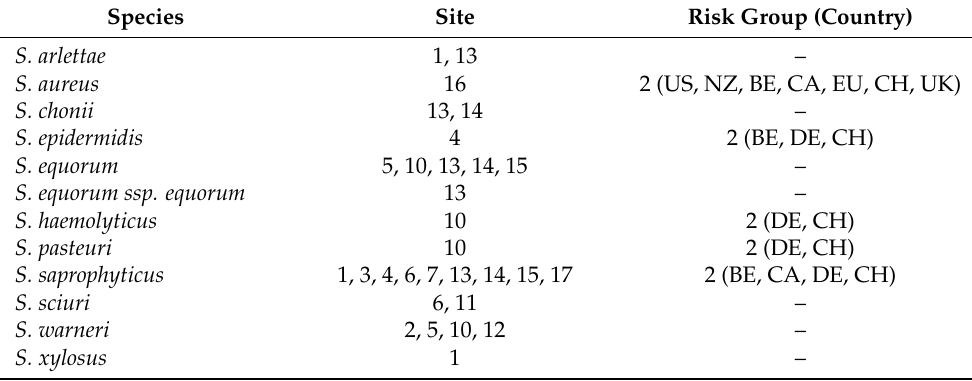
Table 2. Staphylococcus isolates (MALDI-TOF MS score value > 2.000, species level identification) identified in Postojnska jama. Species Site Risk Group